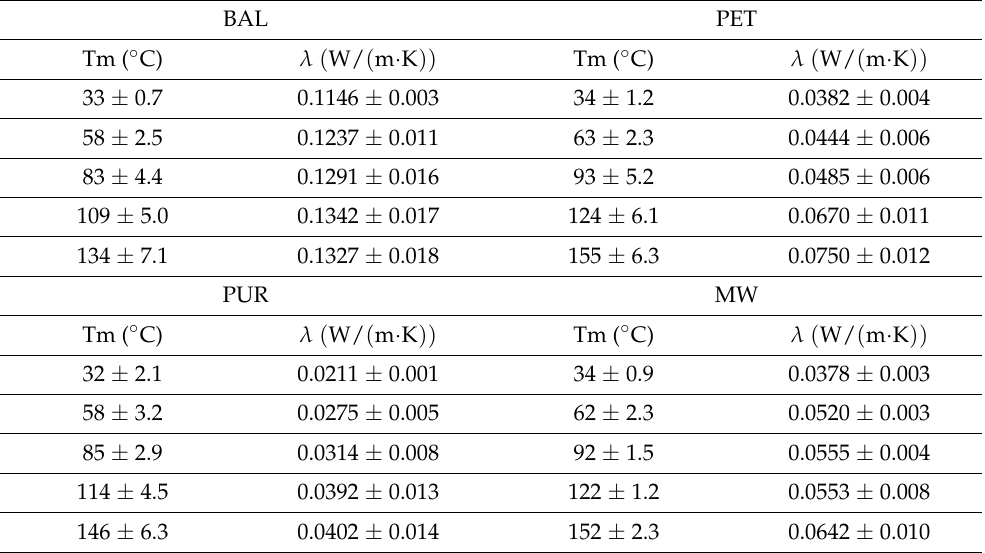
Table 3. Thermal conductivity (W/(m ∙ K)) evaluated for layer 2 (the mean and the standard deviation of three test specimens).